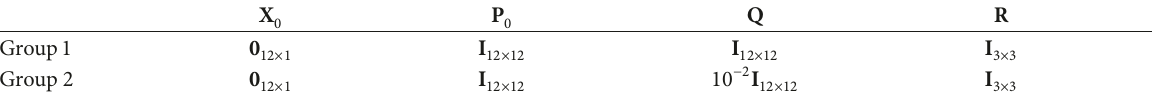
Table 1: The parameters for the tests.